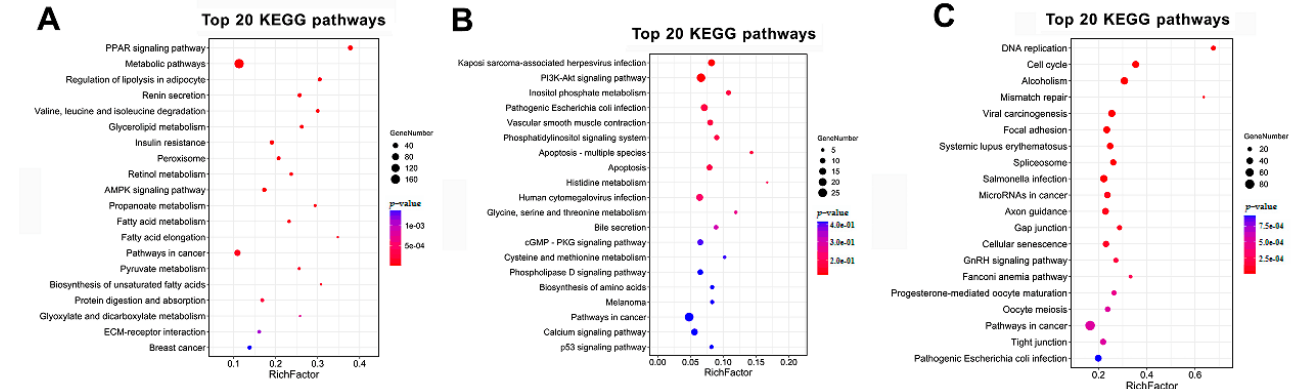
Figure 5. KEGG enrichment analysis of temporal expressed DE mRNAs. ( A ) Significant enriched KEGG pathways for the up-regulated genes during the trans-differentiation. ( B ) Significant enriched KEGG pathways for genes showed changes in the differentiated midsection. ( C ) Significant enriched KEGG pathways for the down-regulated genes during trans-differentiation.